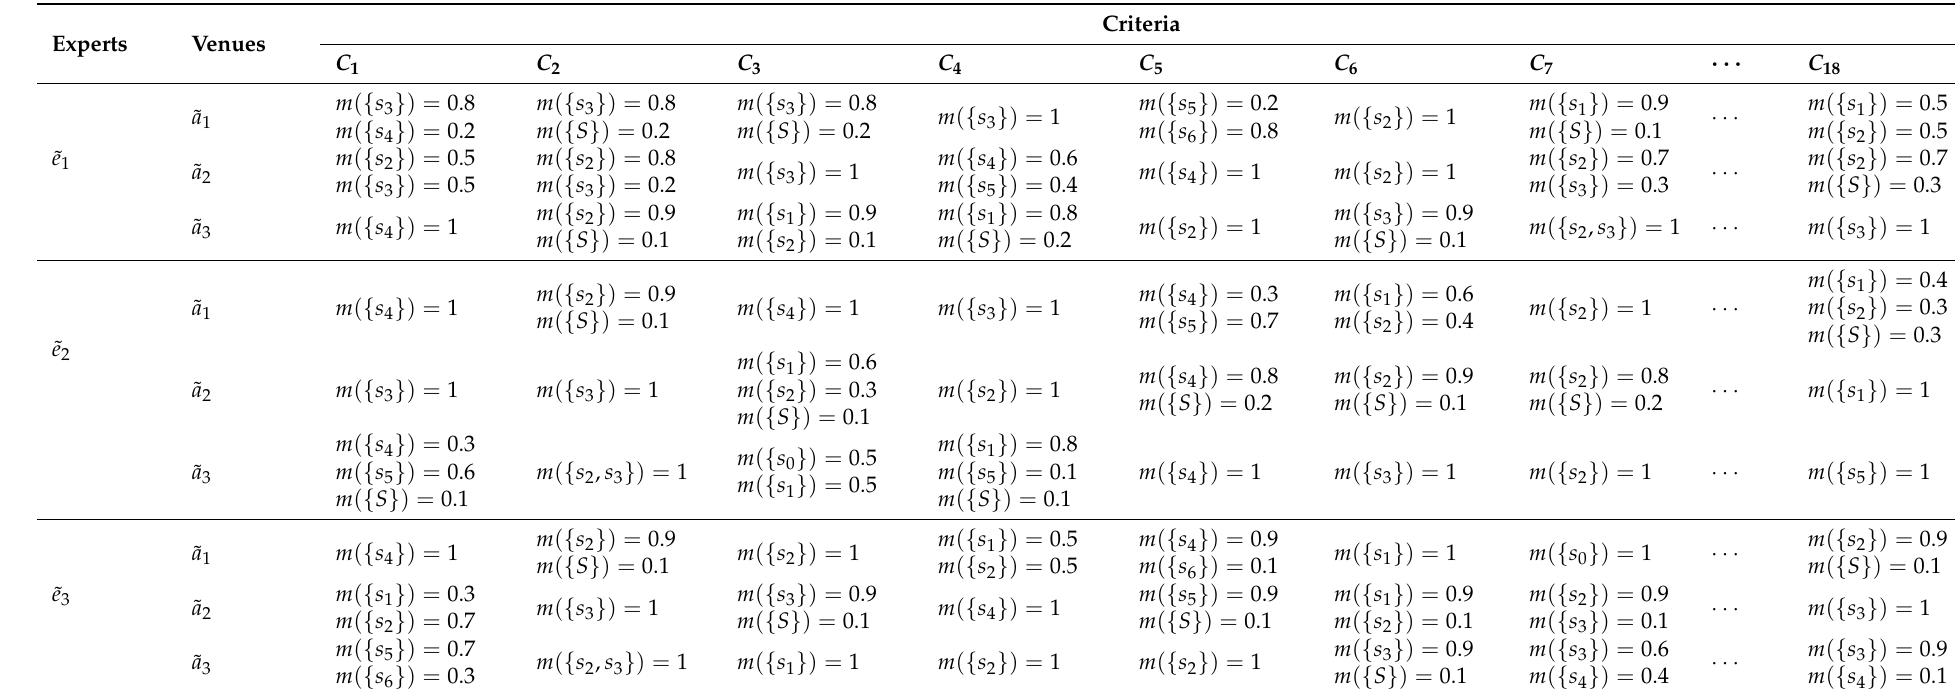
Table 4. Evidential representations of different linguistic evaluation